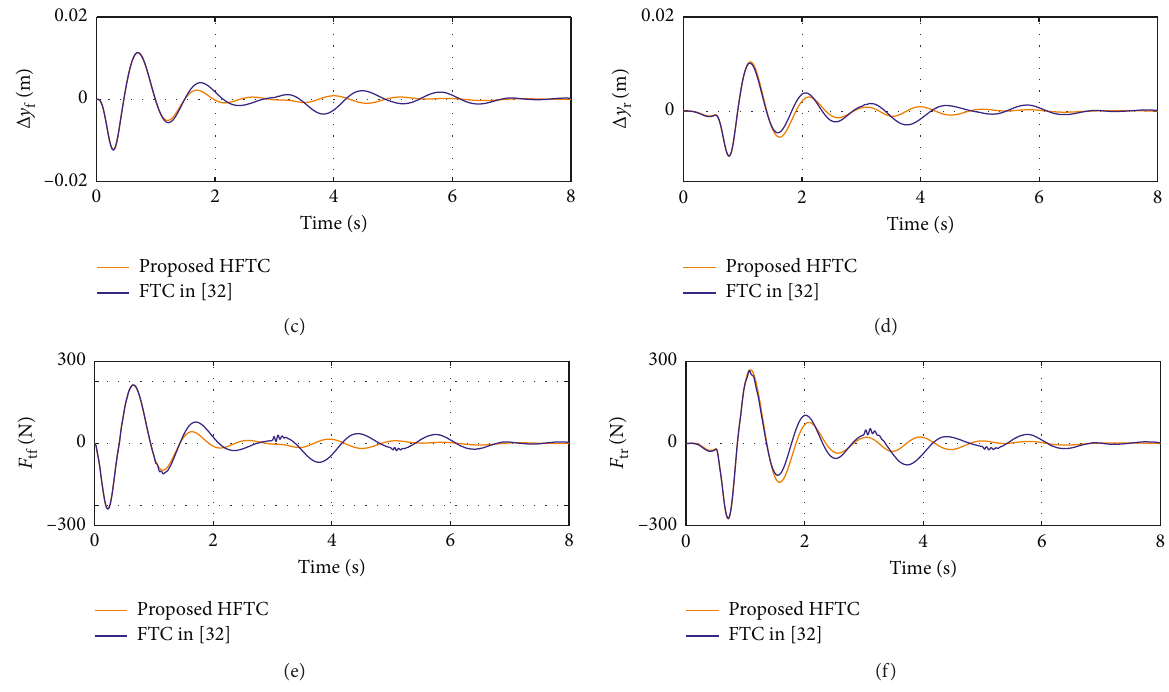
Figure 10: The response comparisons of the ASS with random fault signal under bump road